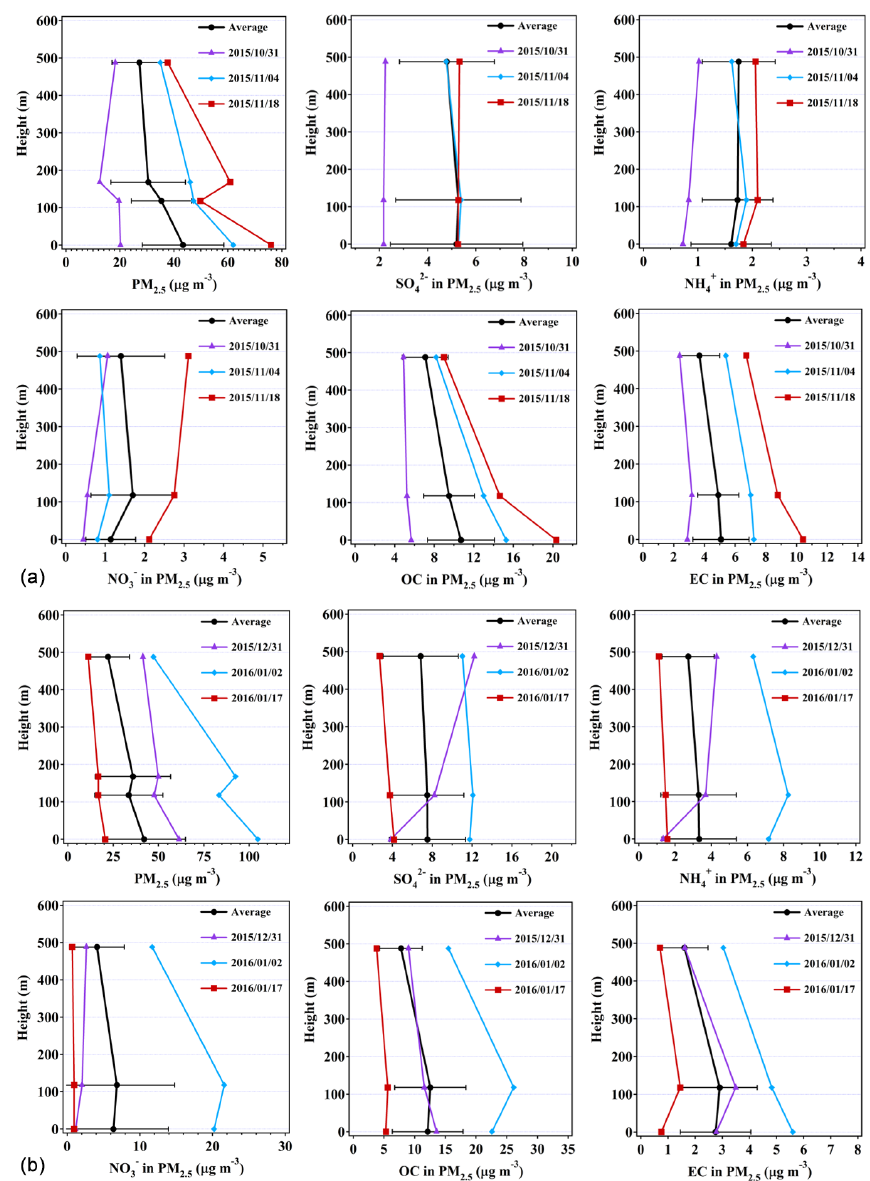
Figure 3. Representative and average vertical profiles of sulfate, ammonium, nitrate, OC, and EC mass concentrations at ground level, 118m, and 488m during (a) autumn and (b) winter. Four layers of PM 2 . 5 mass concentrations are shown here with the data measured by the Guangzhou EMC. Error bars represent standard deviations of the mean. Dates are presented as